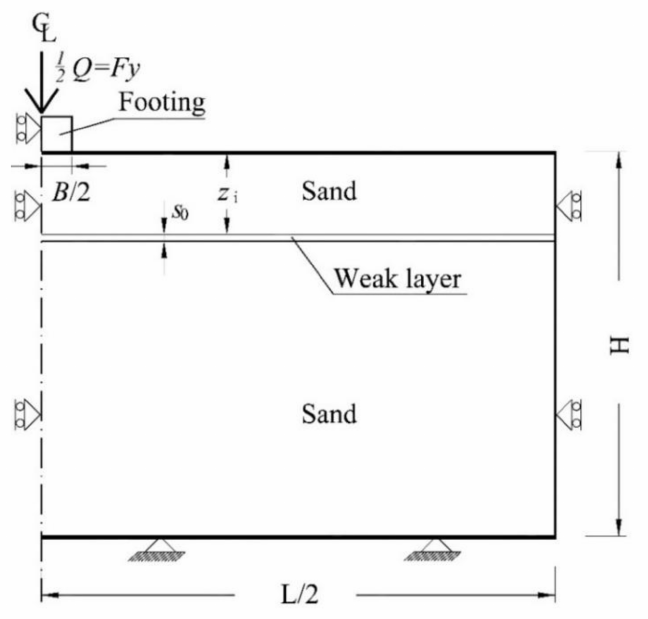
Figure 2. Problem geometry: dimensions and boundary conditions are sketched in the figure (only half of the domain in Figure 1 has been modelled). The horizontal weak layer is located at depth z i from the